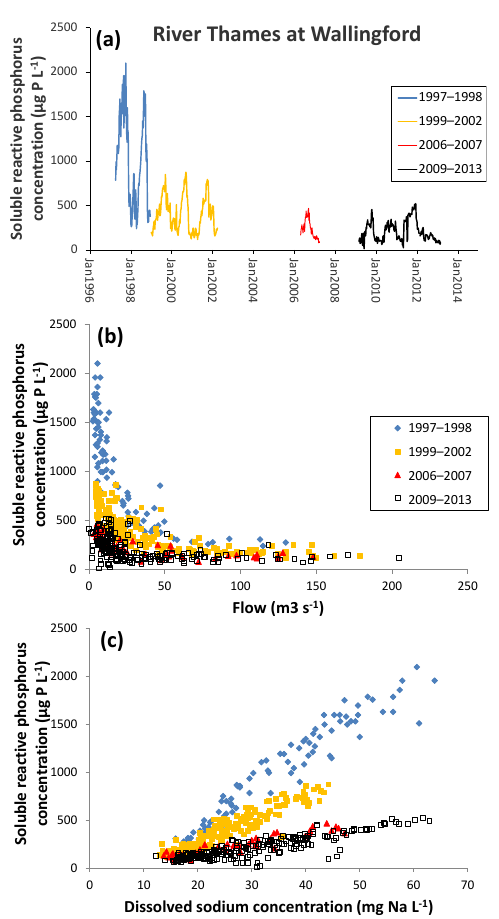
Figure 7. Changes in nitrate concentration in the middle reaches of the River Thames at Wallingford from 1997 to 2013, as (a) a time series, (b) related to mean daily river flow and (c) related to sodium